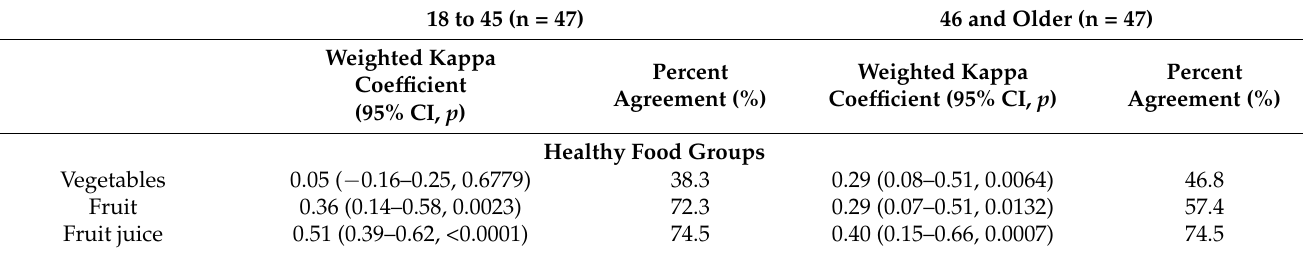
Table 6. Comparison of SPAN MAA and 24 h recall, by age (n =